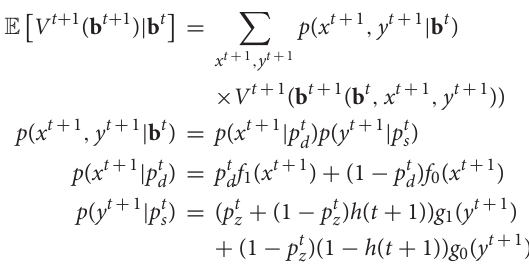
Frontiers in Neuroscience |